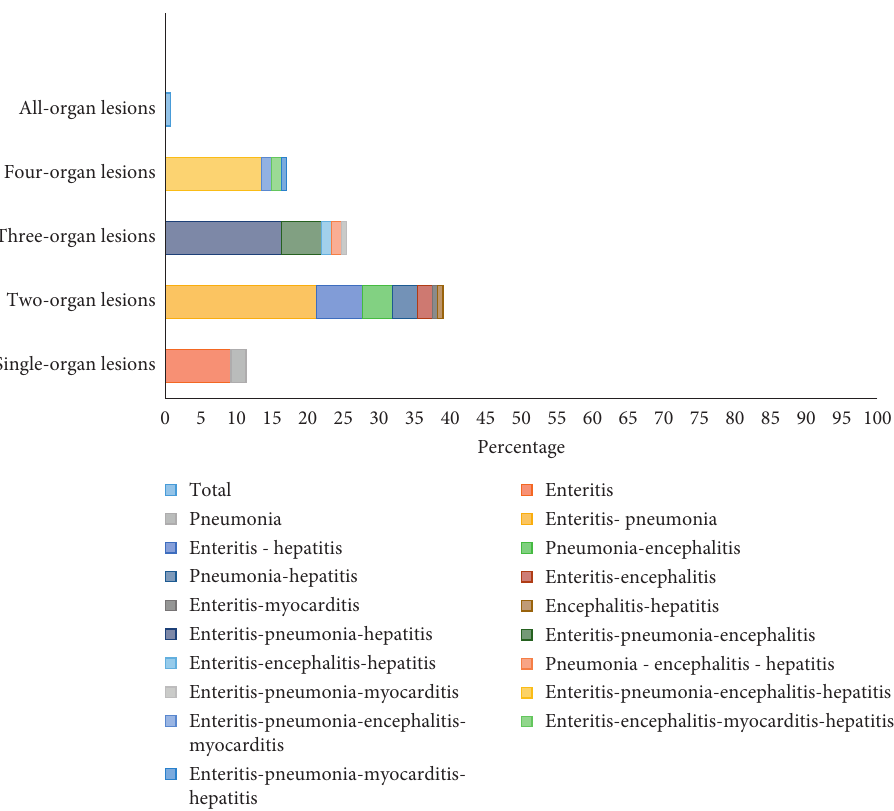
Figure 1: Necropsy reports. Prevalence of single-organ and multiorgan lesions. Table 2: Results of univariate analyses showing the distribution of the lesions in the organs related to the studied variables. No Variables